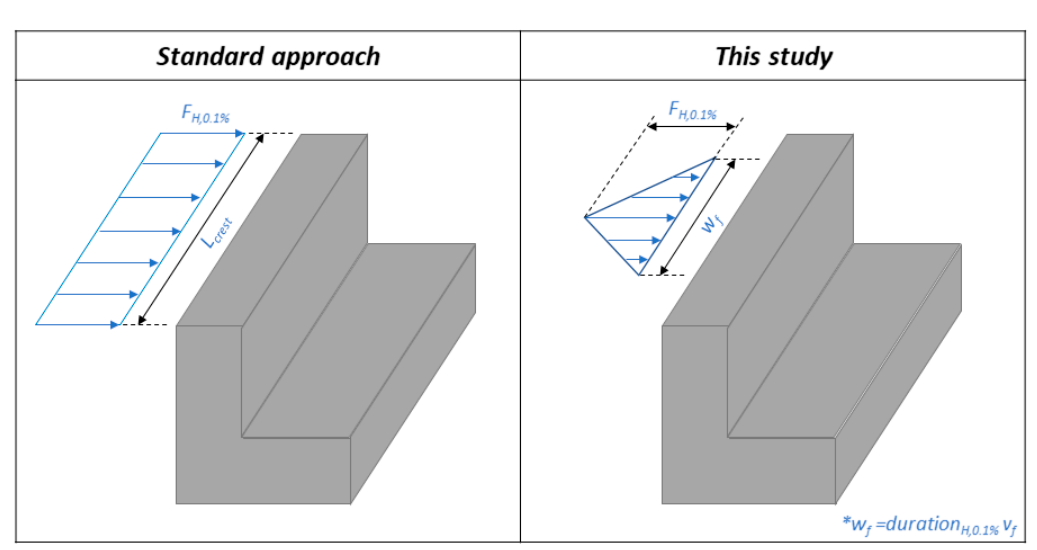
Figure 21. Example of the horizontal force diagram along the longitudinal dimension of the crest wall assumed by the standard method (left panel) and the present study (right panel).